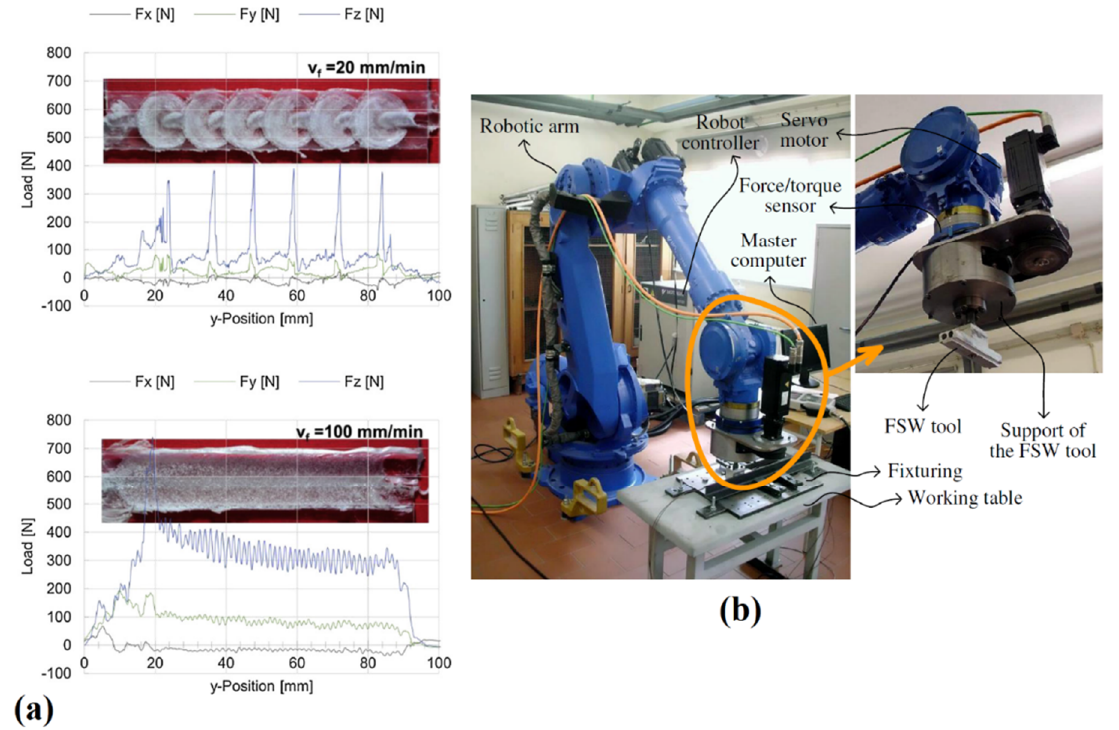
Figure 19. Load measurements during LFSW of ( a ) PC at different V [15] and ( b ) force control robotic system for LFSW of polymeric materials [62].